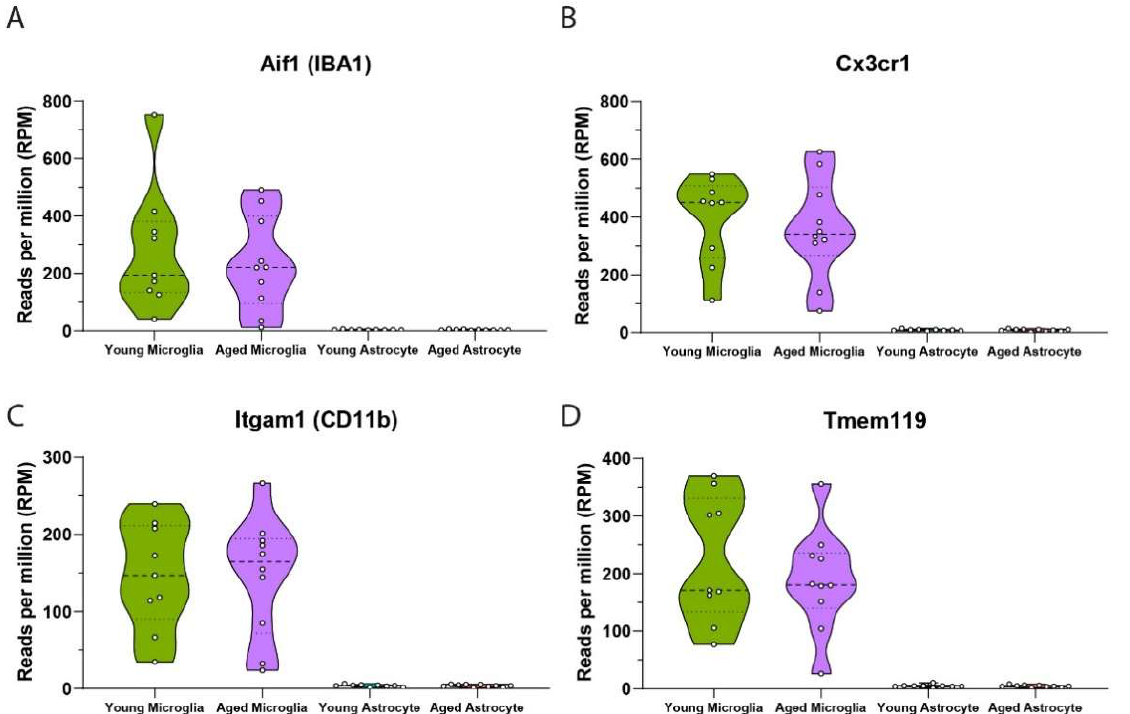
Figure 9. Transcriptomic validation of microglia isolated from adult mouse brain. mRNA analysis shows isolated microglial populations have high expression of microglial specific markers ( A ) Aif1, ( B ) Cx3cr1, ( C ) Itgam1 and ( D ) Tmem119 (young microglia n = 9, young astrocyte n = 9, aged microglia n = 10, aged astrocyte n = 10). Data from 3 independent experiments run on different days, a total of n = 3/day for young mice and n = 3, 3, 4 per day for aged mice.